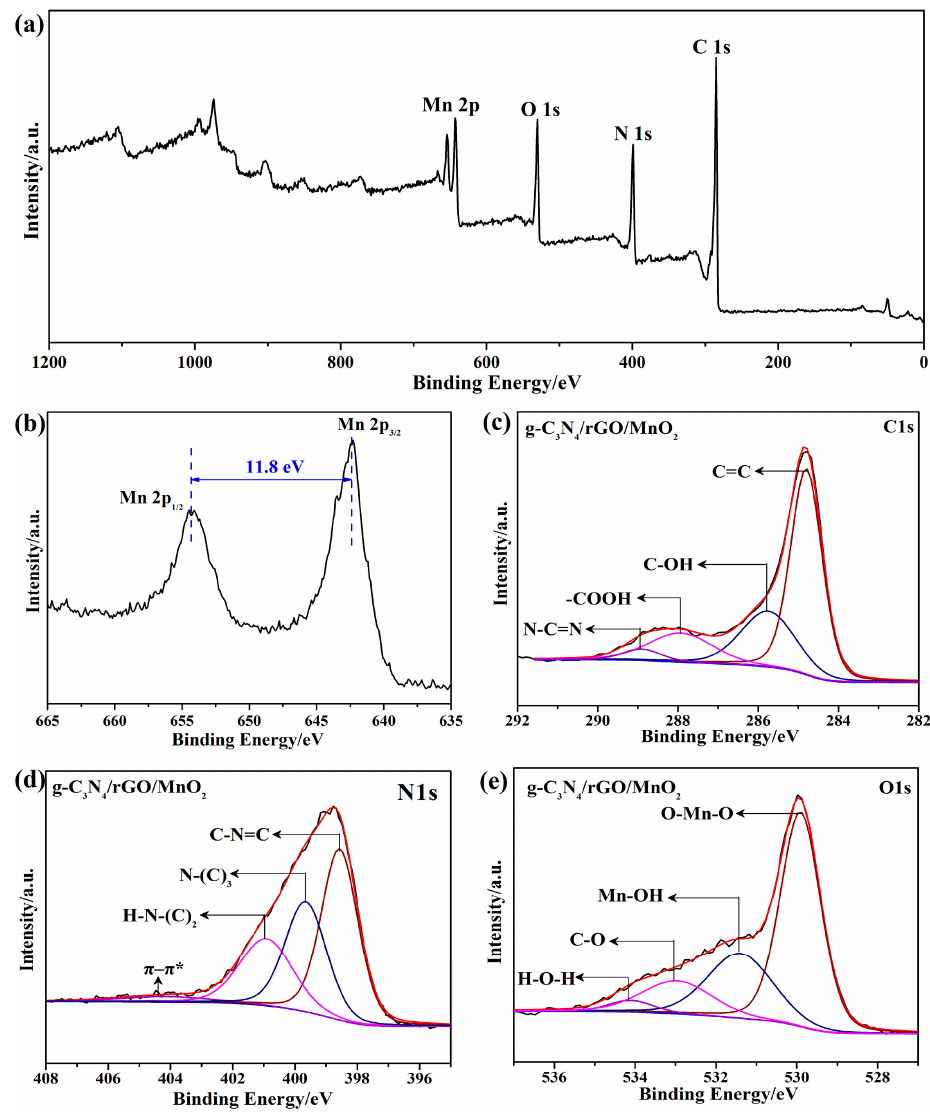
Figure 5. XPS spectra of the g-C 3 N 4 /rGO/MnO 2 ternary nanocomposite: ( a ) full scan, ( b ) high resolution Mn 2p, ( c ) high resolution C 1s, ( d ) high resolution N 1s, ( e ) high resolution O 1s.